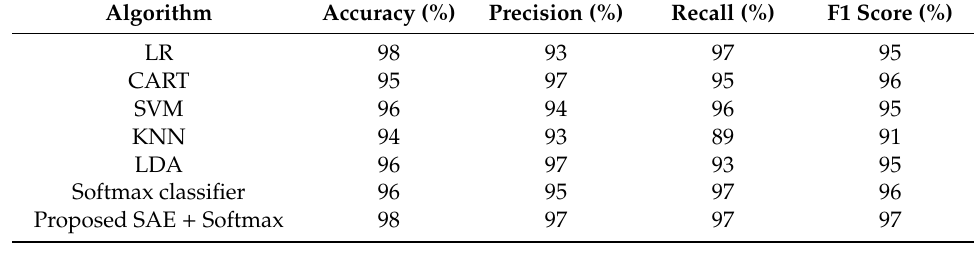
Table 3. Performance of the proposed method and other classifiers on the chronic kidney disease (CKD) dataset.